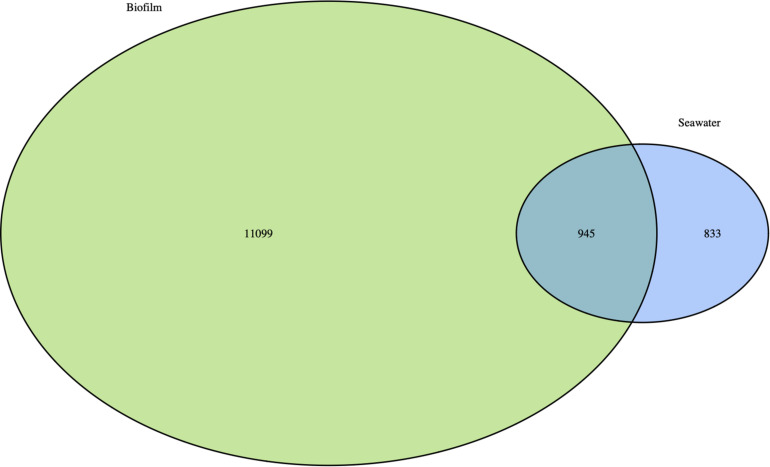
Venn diagram showing prokaryotic OTUs overlap for pooled biofilm samples, and seawater samples at Toulon Bay. Numbers inside the circles represent the number of shared or unique OTUs for the given environment.